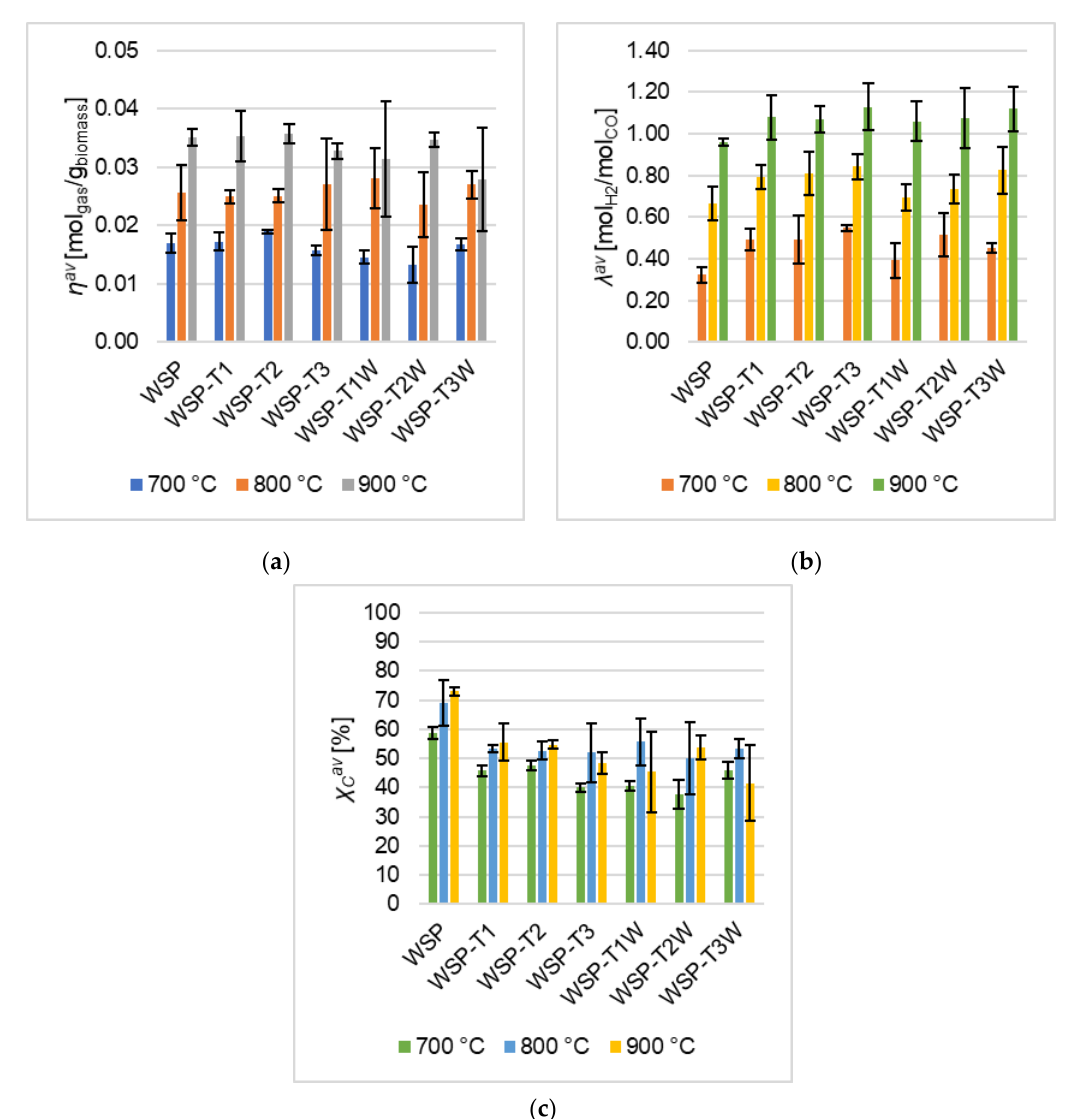
Figure 2. Experimental results of devolatilization tests for all kind of pellets, as functions of temperature (700, 800, and 900°C): ( a ) integral average gas yield ( η av , Equation (1)); ( b ) integral average H 2 /CO molar ratio ( λ av , Equation (2)); ( c ) integral average carbon conversion ( χ cav , Equation (3)); WSP data adapted from [10].